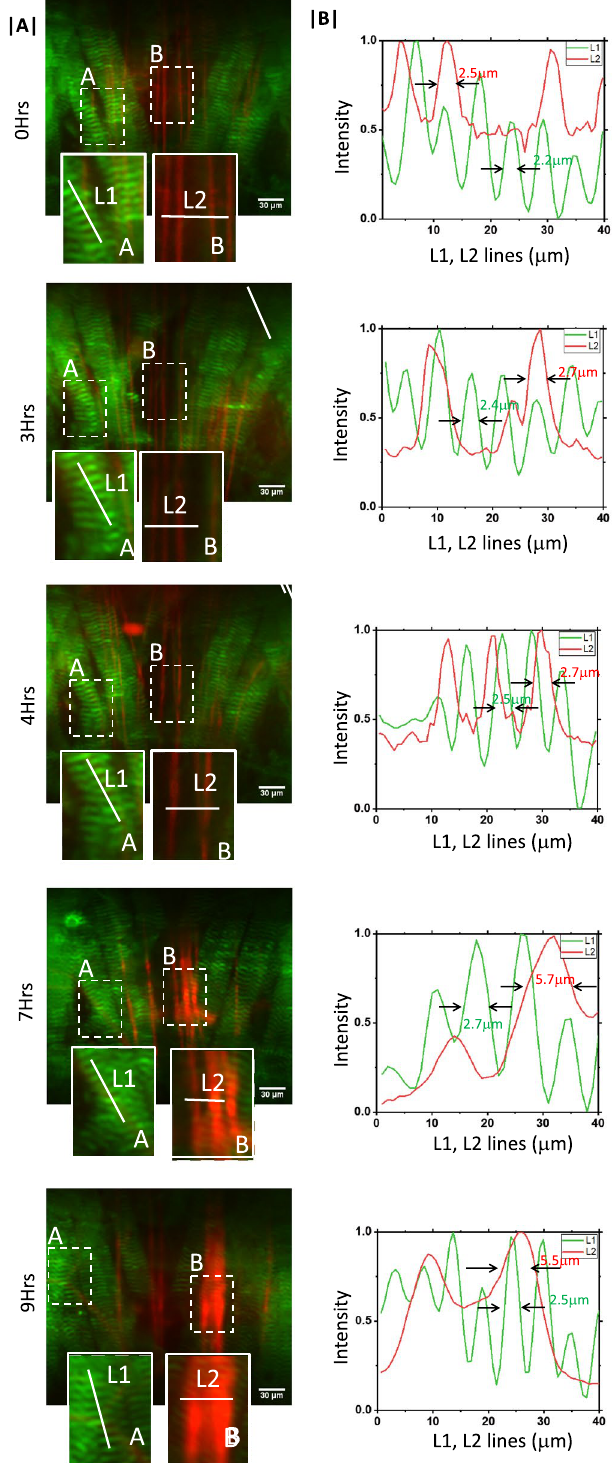
Figure 4. ( A ) 10 h time-lapse imaging of transgenic Drosophila sample showing the development of muscle and neuron over time. ( B ) The corresponding intensity plots that demonstrates the periodic structure of muscle and its development over time. Visualization of fine periodic structures are made possible by high resolution sCMOS